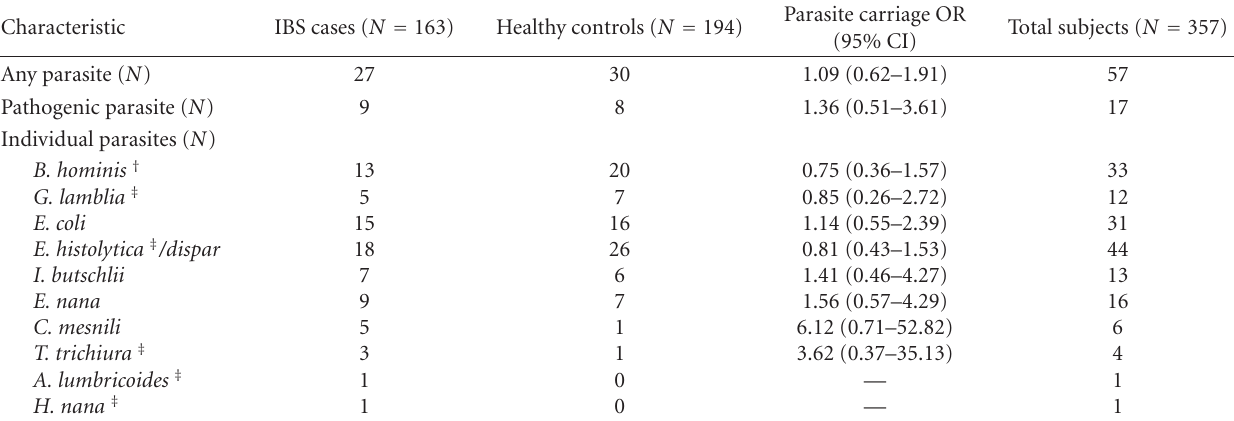
Table 2: Parasite carriage among IBS cases and healthy